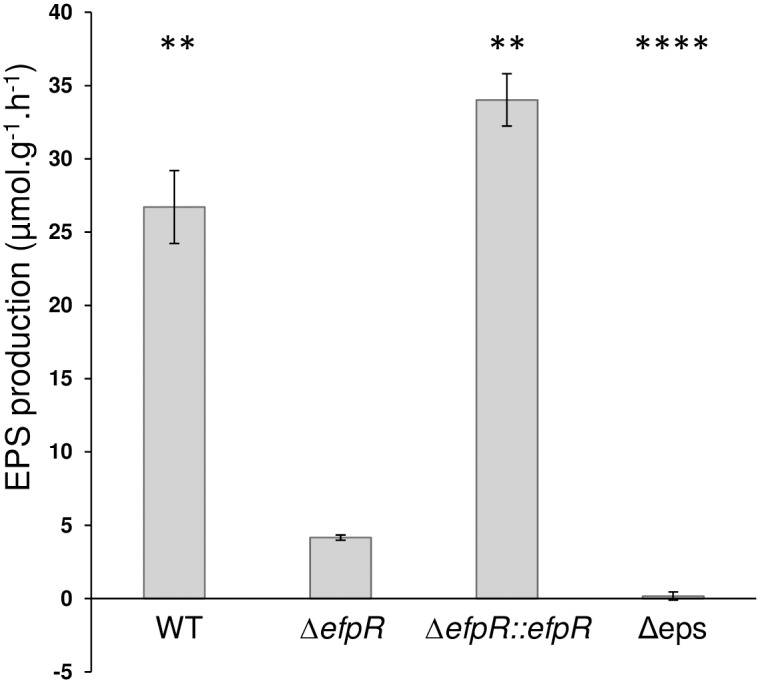
Deletion of efpR results in impaired EPS production of R. solanacearum GMI1000.Kinetic of EPS quantification has been done on minimal medium supplemented with 20mM glutamate, using the Elson Morgan Assay. Three biological repeats were conducted per strain. Bars indicate standard deviation (Welch t-test, comparison with the ΔefpR strain, ** p-value <0.01, ****p-value <0.0001).